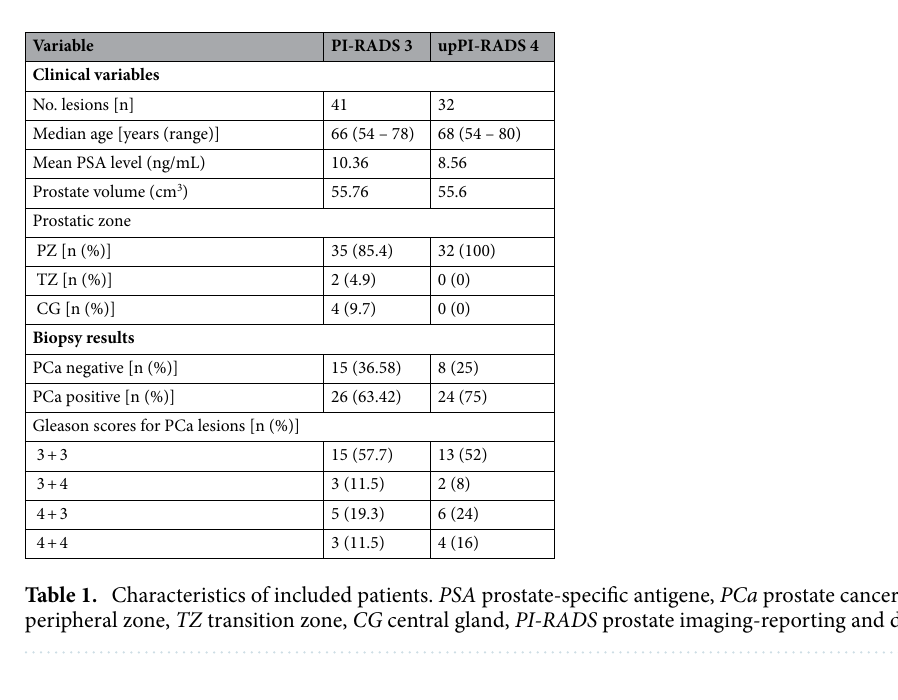
Figure 1. Flowchart showing how final cohort was selected. PI-RADS prostate imaging reporting and data system, upPI-RADS 4 lesions scored as PI-RADS 4 after mpMRI PI-RADS assignment but evaluated as PI-RADS 3 after biparametric MRI reading session.